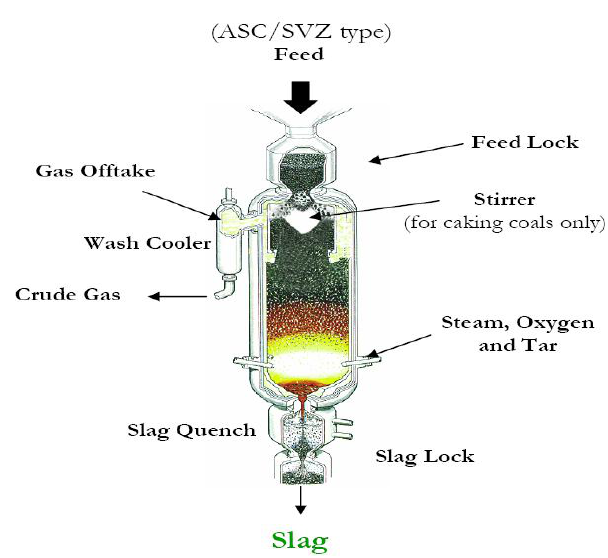
Figure 11. British Gas Lurgi Gasifier